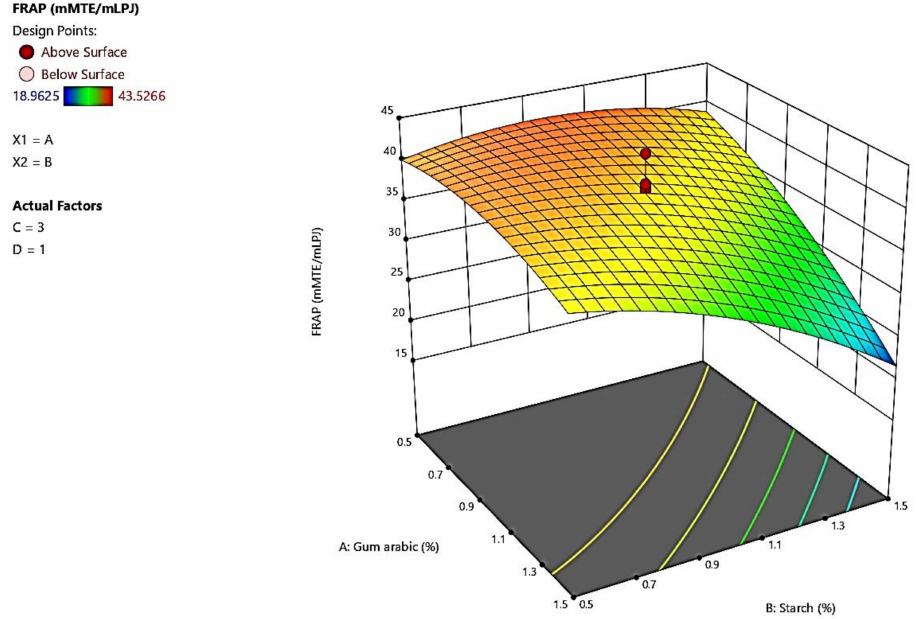
Figure 6. Response surface plot for ferric reducing antioxidant power (mMTE/mL PJ) of coated “Wonderful” pomegranate as a function of gum arabic and maize starch and concentration.